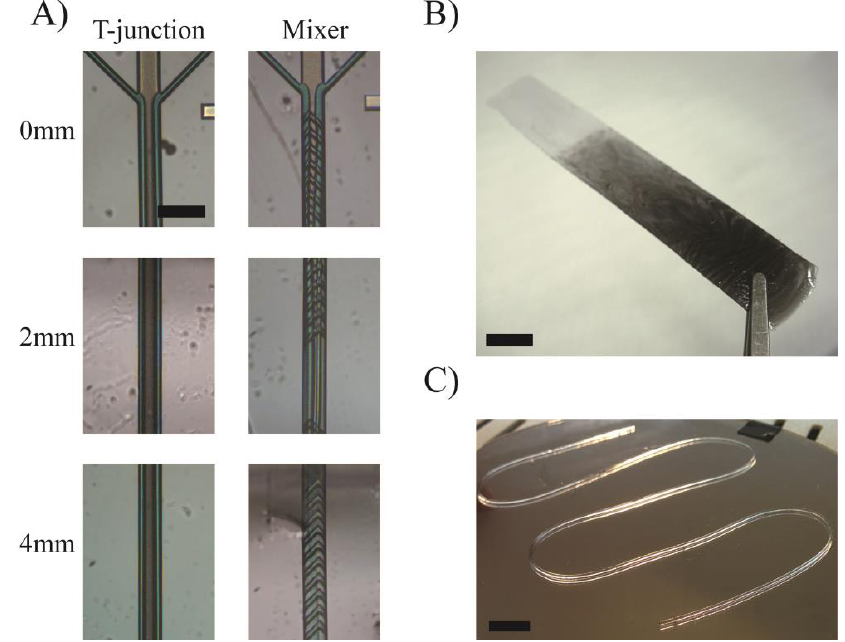
Figure 3. Herrigbone micro-mixer integrated at the tip of the probe. ( A ) Colored glycerol streams pushed through a simple T-junction and through a herringbone micro-mixer at 0 mm, 2 mm and 4 mm after the merging point. The mixer allows rapid and efficient mixing of viscous materials. Scale bar = 300 µm. ( B ) Mixing of white and black Formlabs resins at different ratios results in smooth gradients from one material to the other Scale bar = 1 cm. ( C ) Printed acrylate filament made using a two-component material. Scale bar = 1 cm.